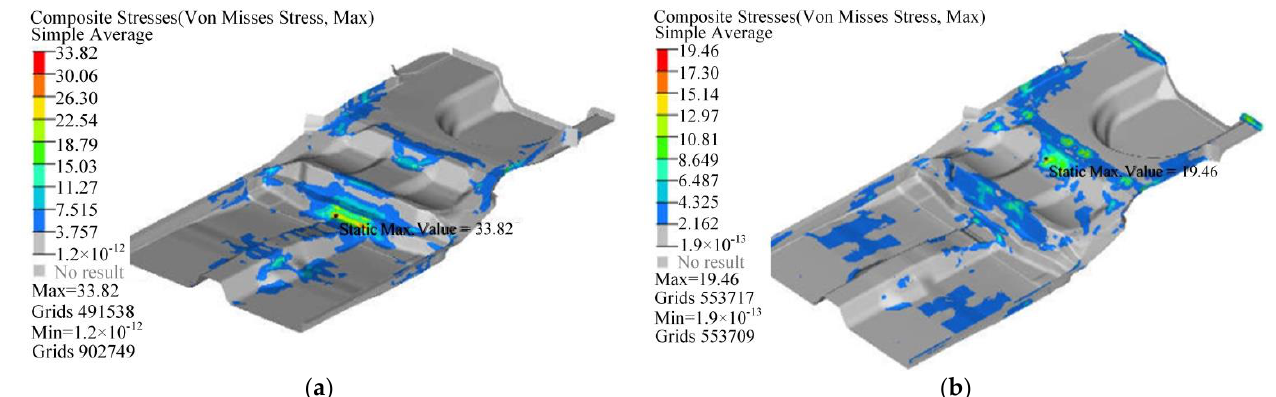
Figure 22. Distribution of failure index of composite floor: ( a ) Bending condition; ( b ) Torsional condition.